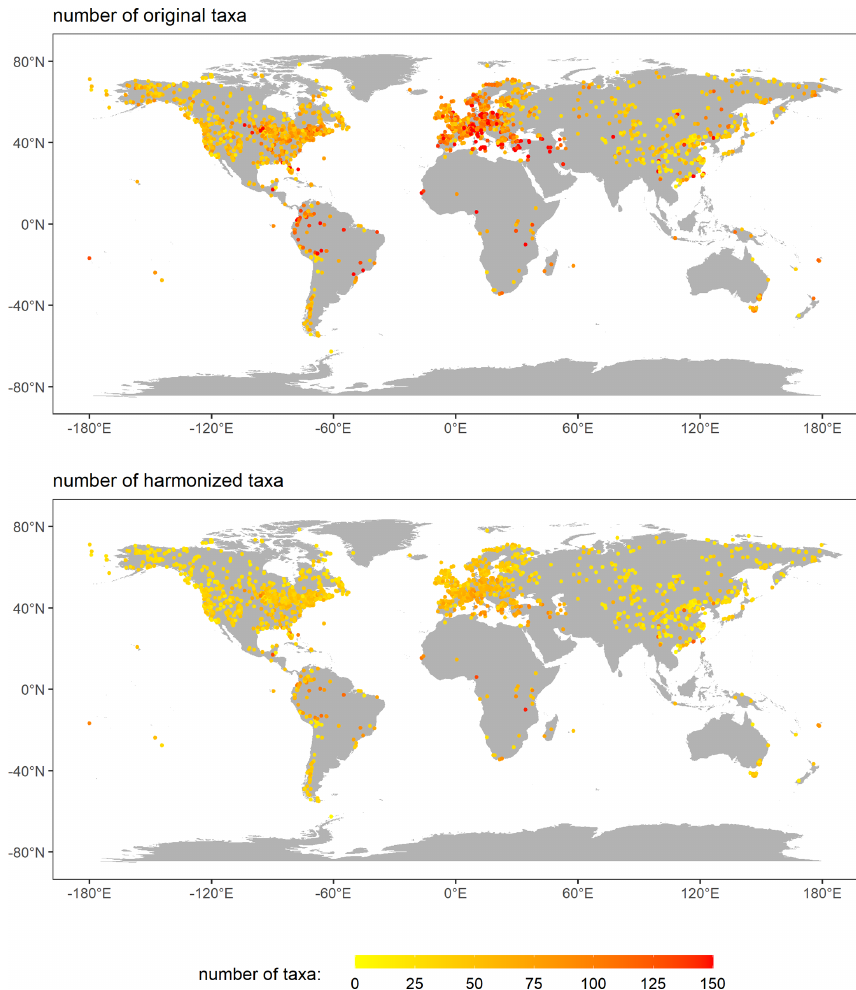
Figure 4. Number of taxa before and after harmonization. Note that the color legend does not extend beyond 150, so records with > 150 taxa are plotted in the color corresponding to 150 taxa on the